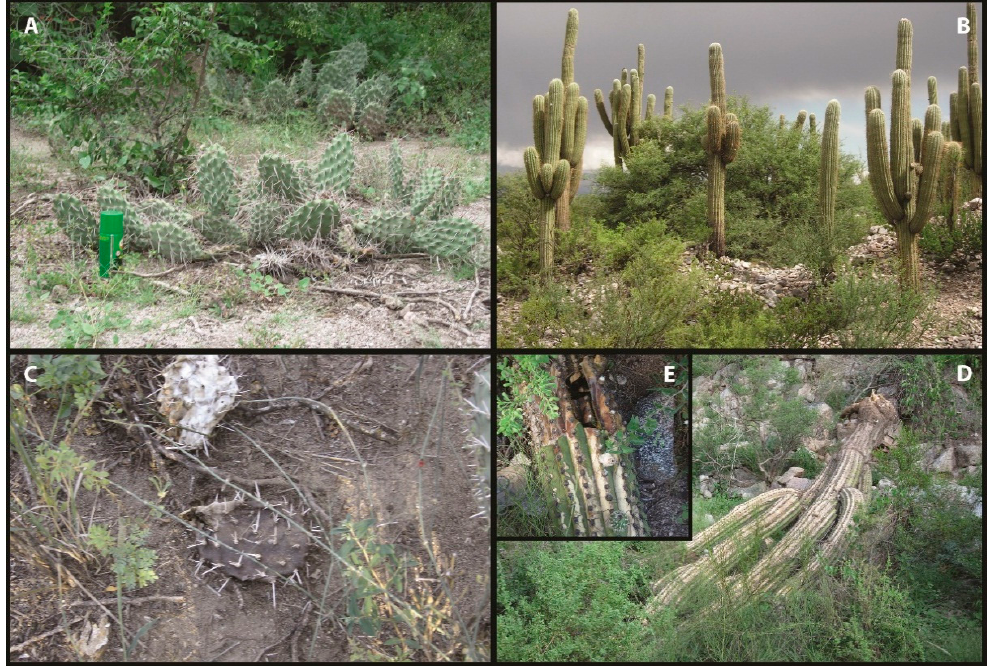
Figure 1. Natural host plants of cactophilic Drosophila in Argentina. ( A ) Opuntia sulphurea ; ( B ) Trichocereus terscheckii ; ( C ) Rotting cladodes of O. sulphurea ; ( D ) Decaying tissues of T . terscheckii ; ( E ) Zoom in rotting tissues of T . terscheckii .